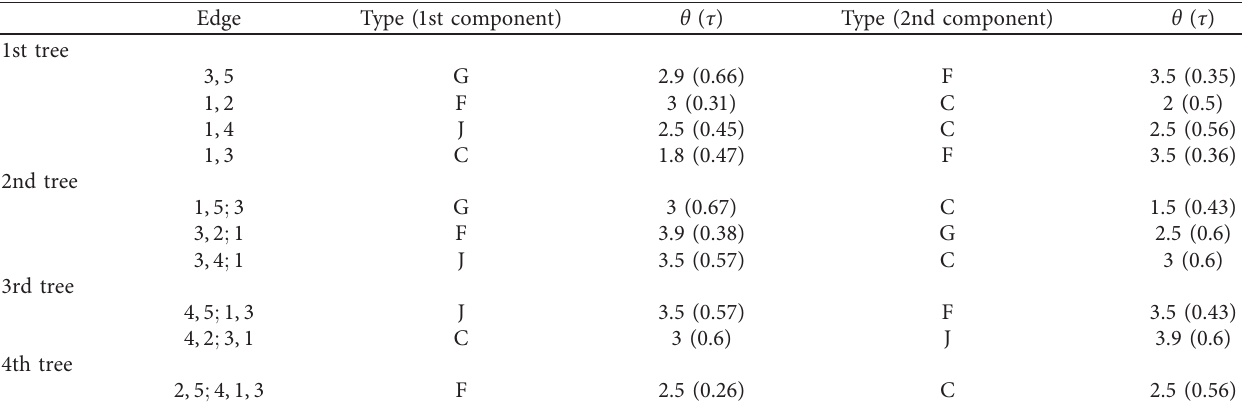
Table 1: Summary of the mixture of R-vine density model (simulated data of size